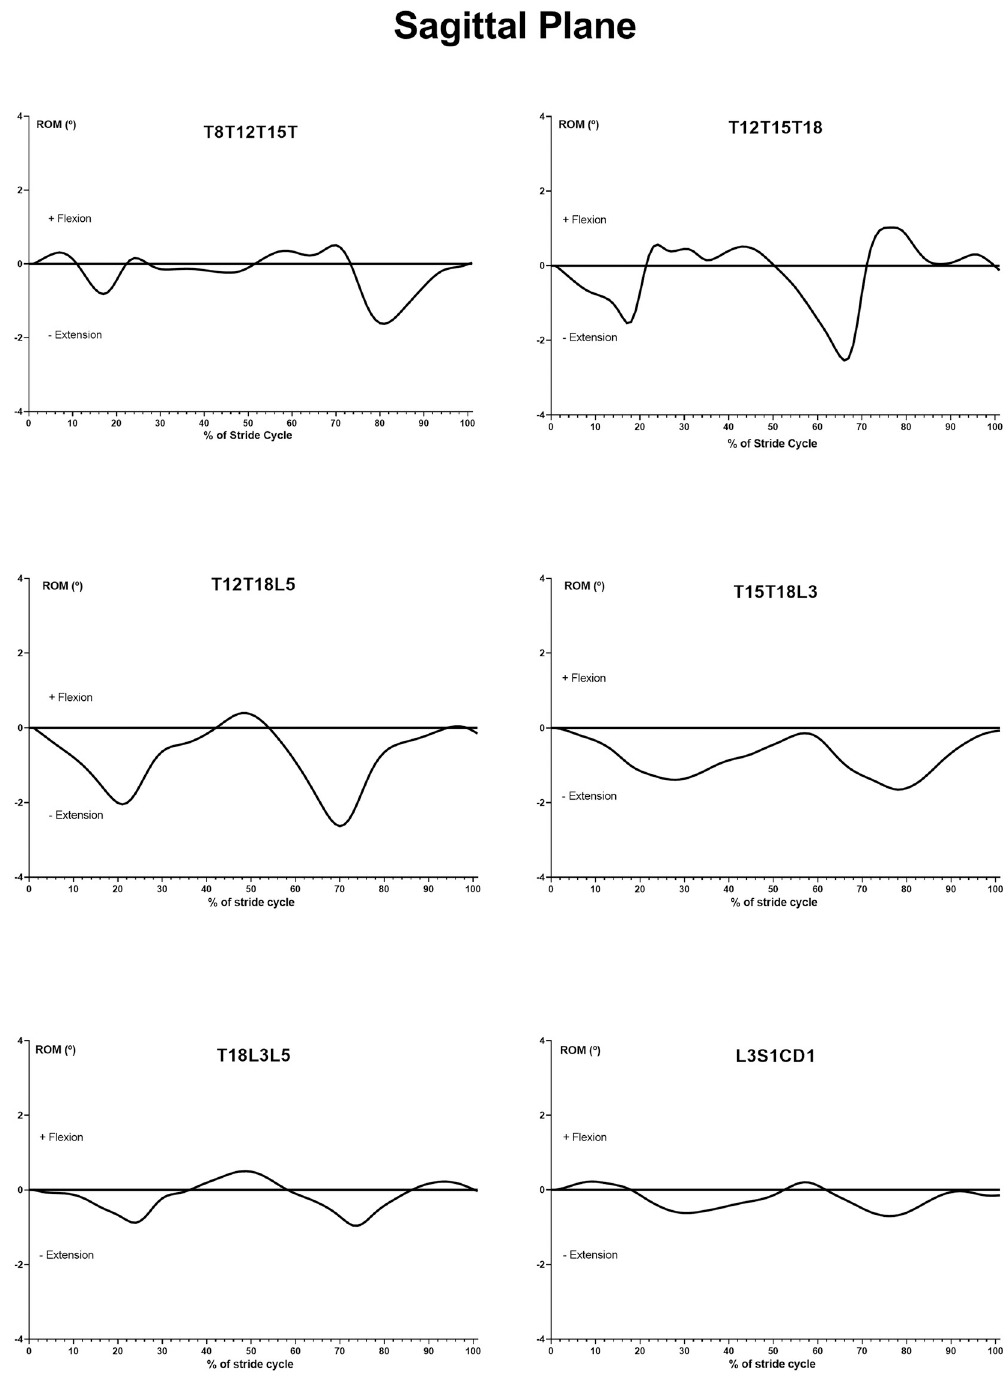
Fig 4. Typical example of mean curve of angular motion pattern (AMP) of the T8-T12-T15, T12-T15-T18, T12-T18-L5, T15-T18-L3, T18-L3-L5 and L3-S1-Cd1 angles in the sagittal plane, in relation to the average of both stride cycles. [18], greater latero-lateral movement was observed with values ranging from 3.6 to 5.4 degrees in the segments T13-T17-L1 and L1-L3-L5. Thus, when comparing with the find- ings in trotting horses [16,18] at similar speeds, the marcha batida gait provides reduced